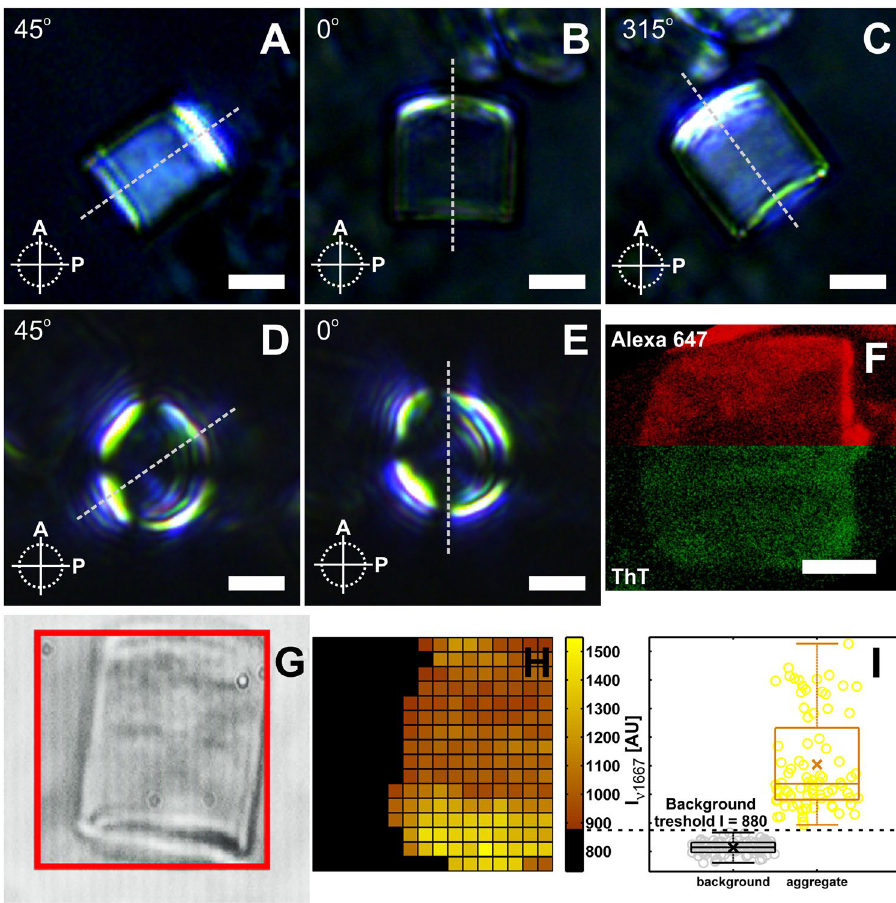
Figure 2. PLM, CLSM and CRM images of SFAs. Side view PLM images of SFA rotated at ( A ) 45°, ( B ) 0° and ( C ) 315° relatively to the polarization axis of the analyzer. Front view PL micrographs of an SFA at ( D ) 45° and ( E ) 0°. ( F ) Confocal z-stack slice, taken along the length of the cylinder, from the middle section of an SFA formed within the presence of α S140C-Al647 (red) and stained with the amyloid specific dye Thioflavin T (green). Scale bars are 10 µ m. The dashed line guides the eye for the relative rotation of the aggregate with respect to the crossed polarizers. In the top row ( A – C ) the line coincides with the central axis of the aggregates. The red frame in the 40 × 40 μ m transmission image ( G ) designates the field of view for the CR mode of the microscope. ( H ) Background pixels which have intensity below the threshold of 880 AU ( I ) are colored in black. All the pixels exceeding the threshold are color coded according to the color scale (above 880 AU) in ( H ).